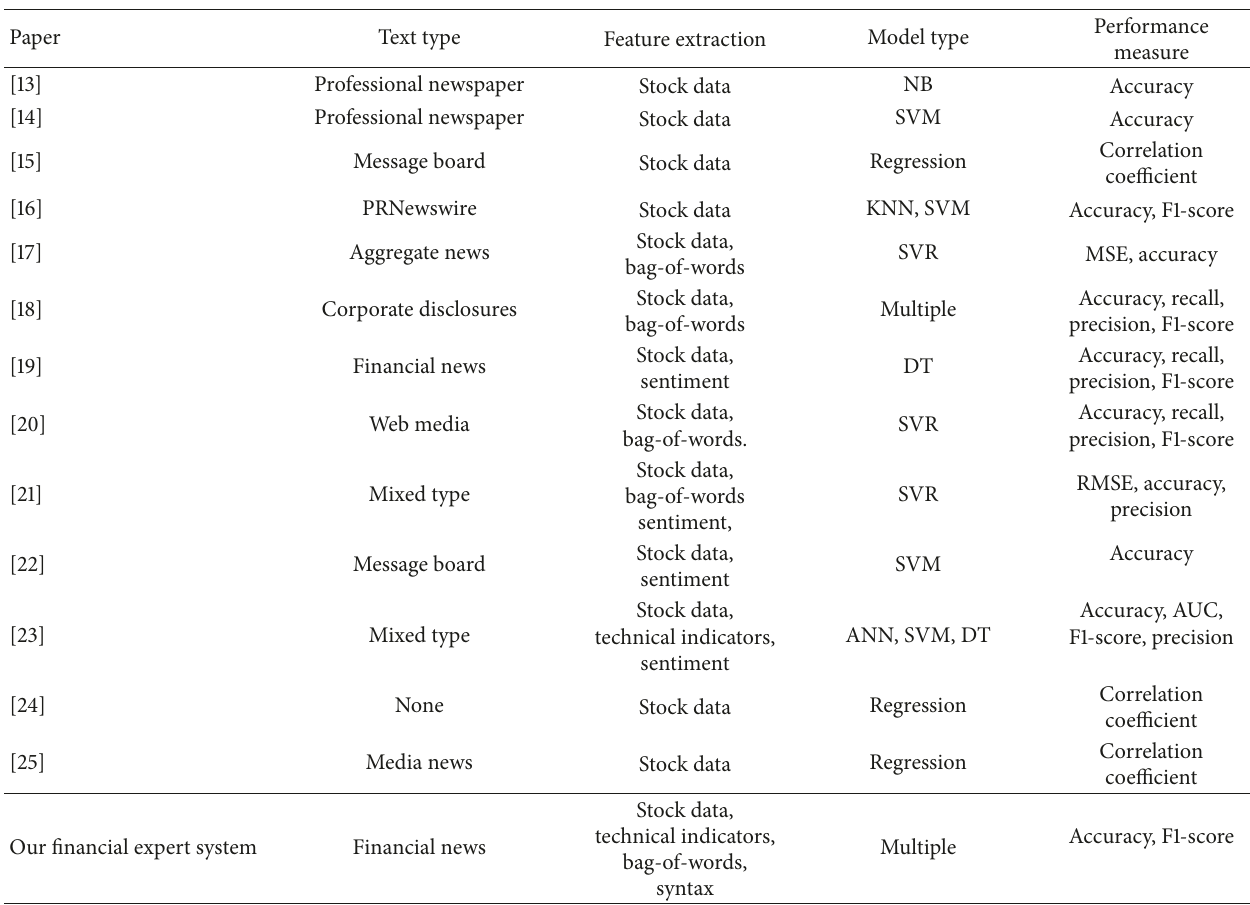
Table 1: A review of financial expert system. ANN, NB, KNN, SVM, DT and SVR stand for artificial neural network, naive Bayes, k nearest neighbors, support vector machine, decision tree, and support vector regression, respectively. Measure metrics: mean squared error (MSE); root mean square error (RMSE); area under the curve